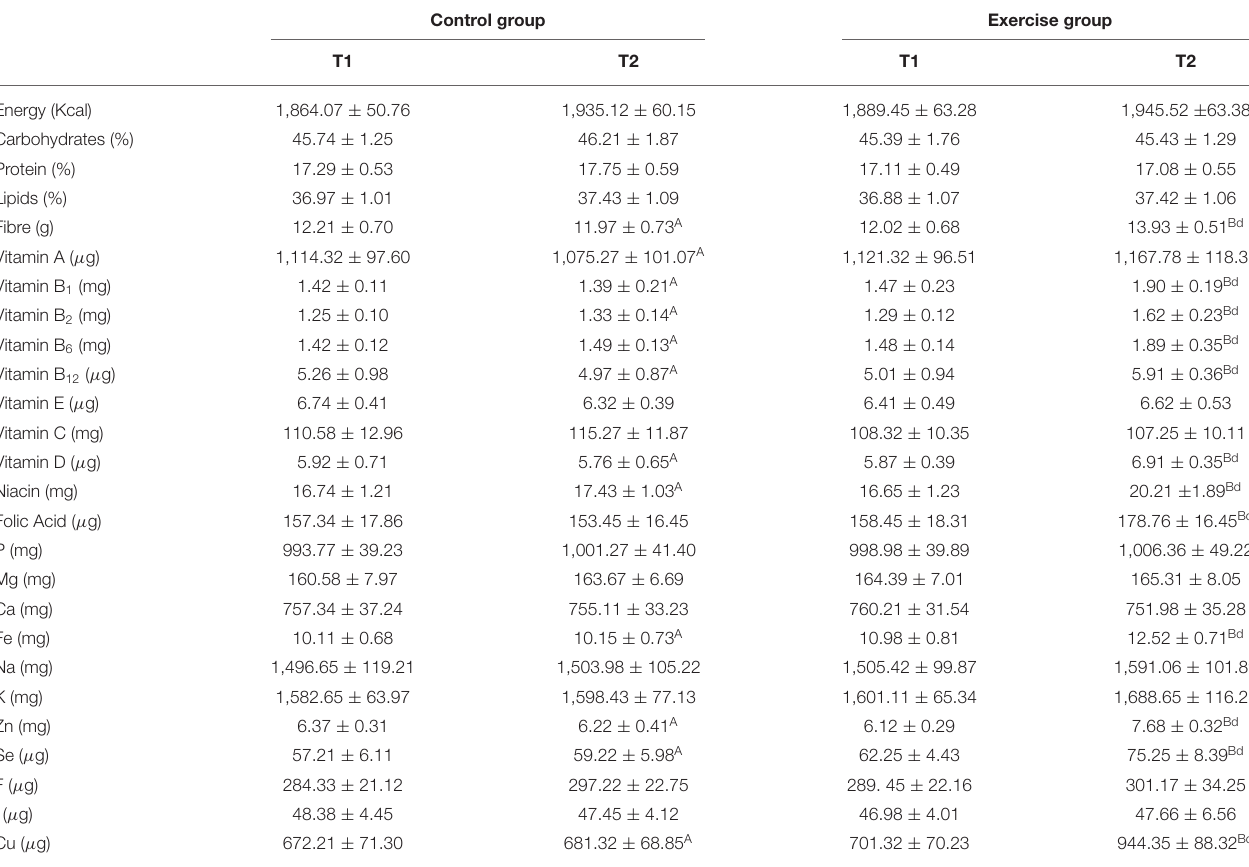
TABLE 3 | Diet composition and nutritional intake analyses from the control and exercise